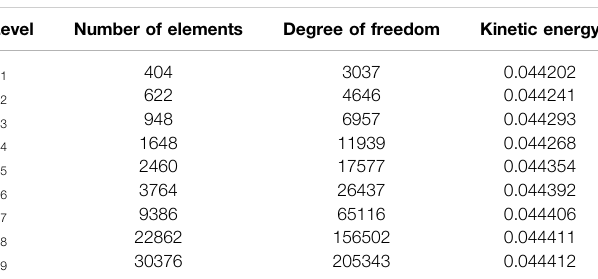
TABLE 1 | Grid convergence test at the extreme fi ne level.